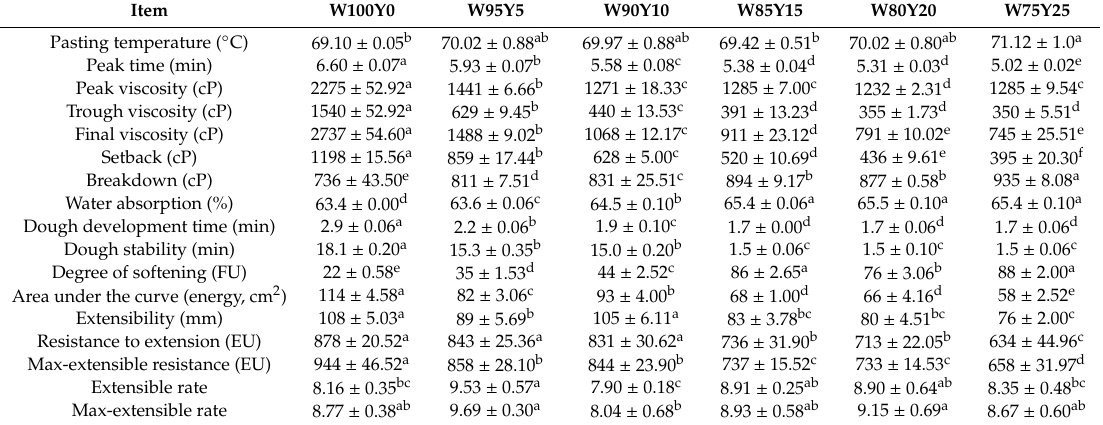
Table 1. E ff ects of yam flour addition on pasting, farinographic, and extensographic properties of mixed flour.